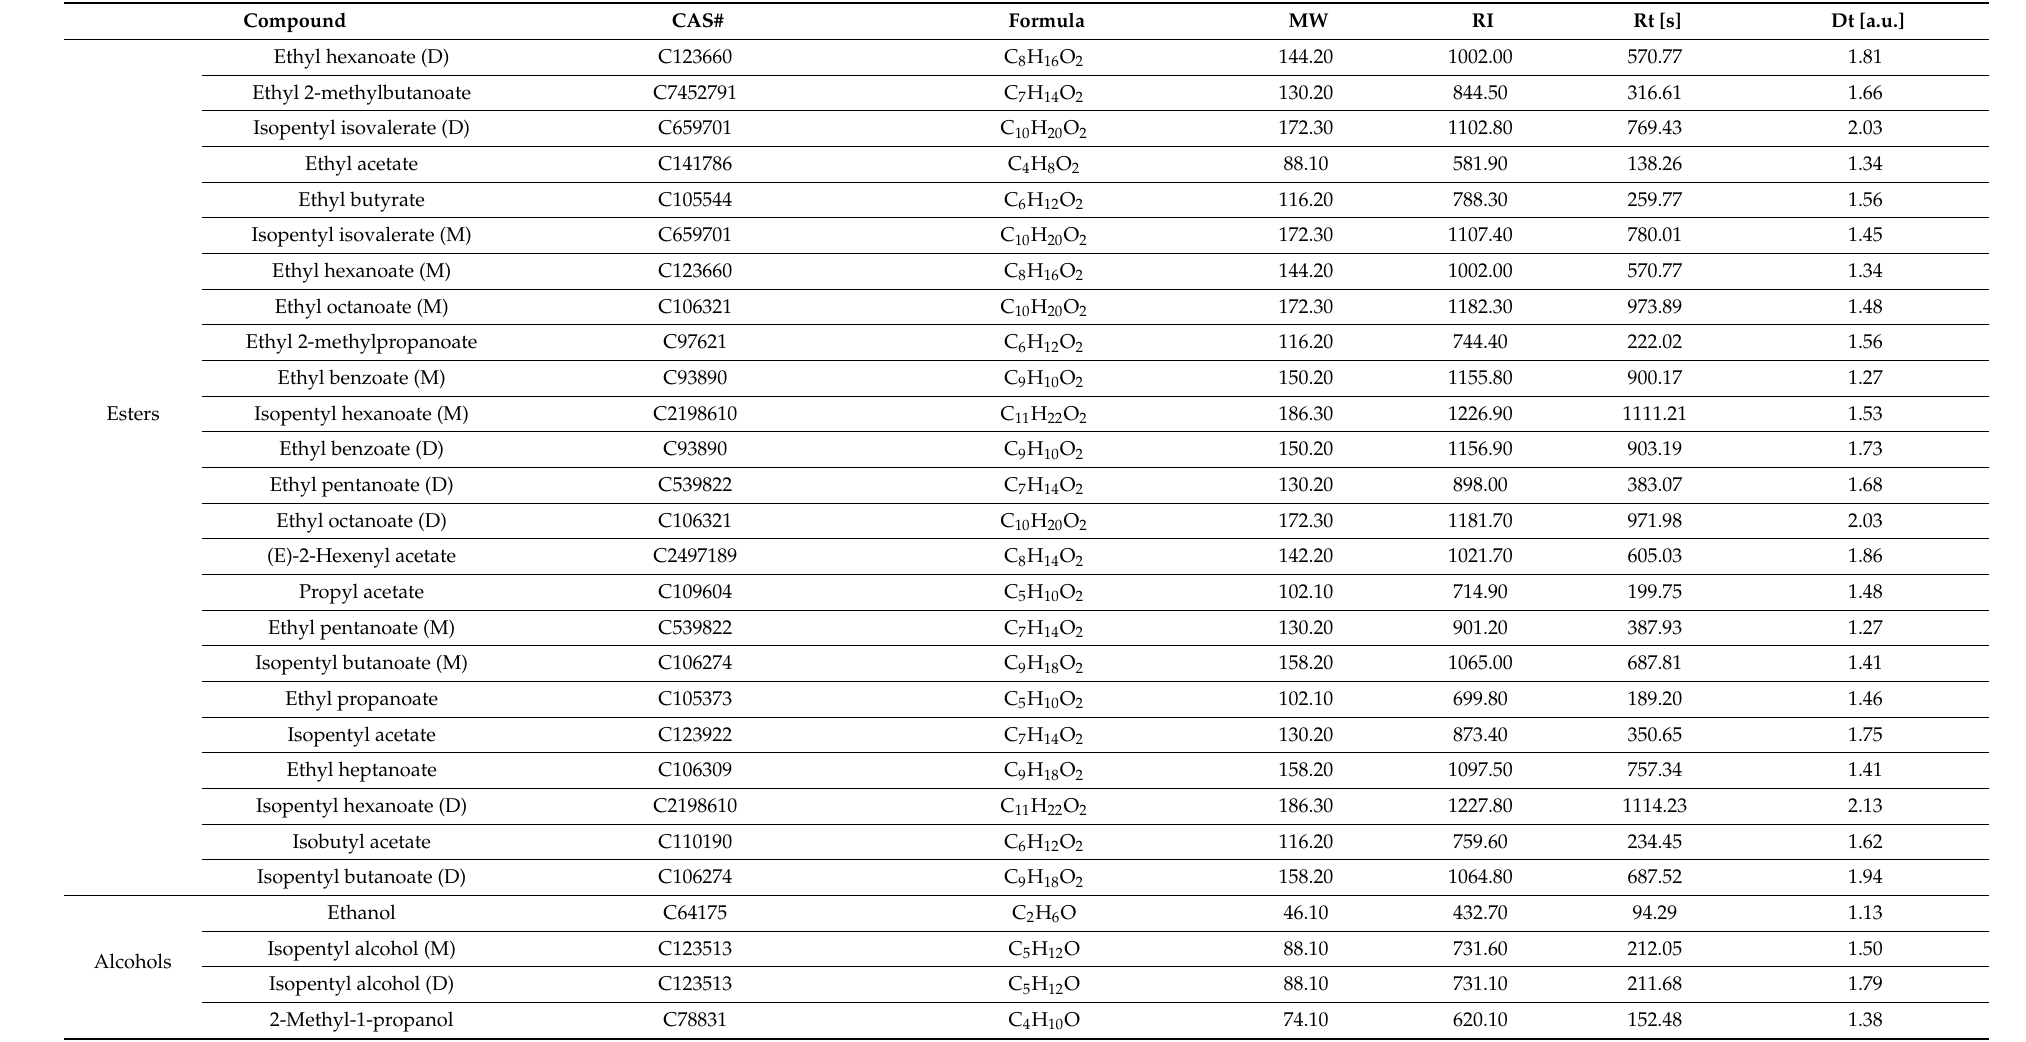
Table 1. The flavor compounds presented in the sea buckthorn juice during fermentation by